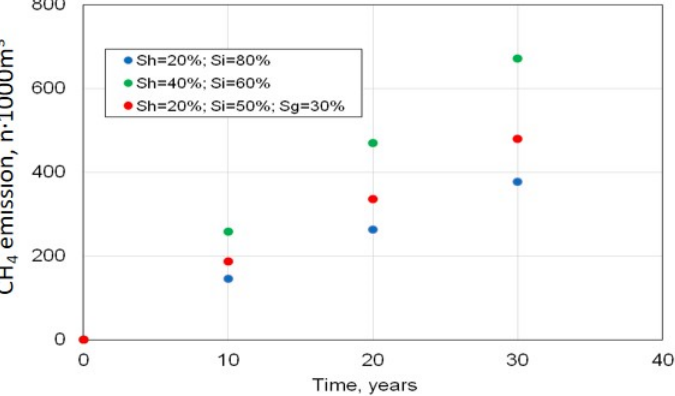
Figure 12. Potential methane emission from gas hydrate-bearing permafrost (60–120 m depth interval) associated with well–permafrost interaction at different hydrate saturation values. S h , S i , and S g refer to hydrate, ice, and gas (methane) saturation, respectively.